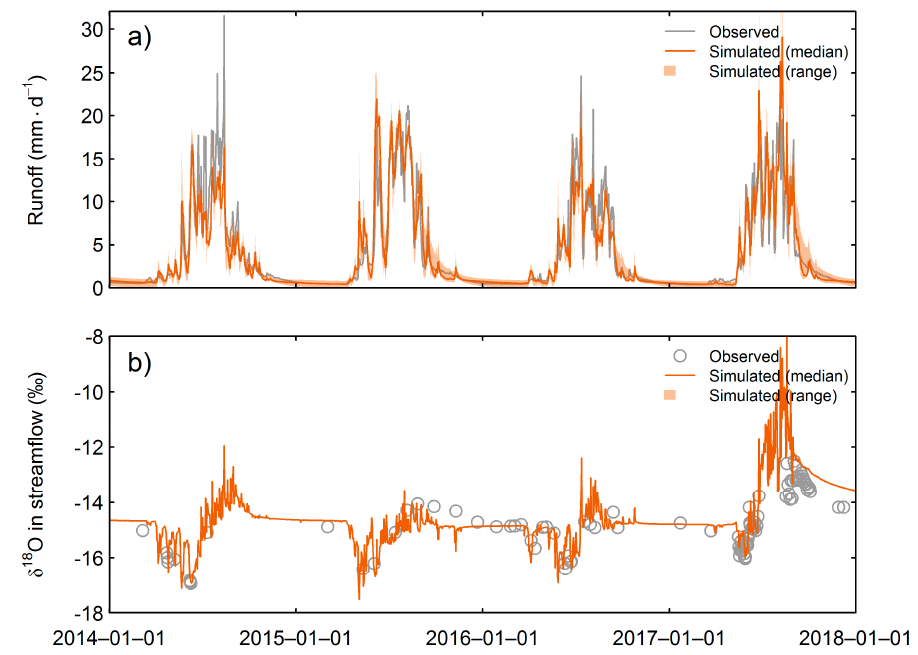
Figure 4. ( a ) Observed and simulated runoff and ( b ) δ 18 O in streamflow for the Rofenache at Vent (1891 m a.s.l.). The orange line shows the median and the orange band marks the range of the best 100 runs. The orange band in ( b ) is very thin and covered by the orange line. Observed and simulated streamflow δ 18 O (median of best 100 runs) also reveal a strong seasonality with the highest values during late summer and the lowest values during the peak snowmelt period in late spring (Figure 4b). The simulated δ 18 O values ranged from − 17.6‰ to − 7.8‰ with respect to the best 100 TRANSEP simulations (the orange band in Figure 4b is very thin and covered by the orange line). The range of the 98 observed streamflow δ 18 O values was –16.9‰ to − 12.5‰. During winter baseflow conditions (December to March), the simulated δ 18 O values with a range of − 15.3‰ to − 13.4‰ (median of the best 100 TRANSEP runs) were close to the median of the